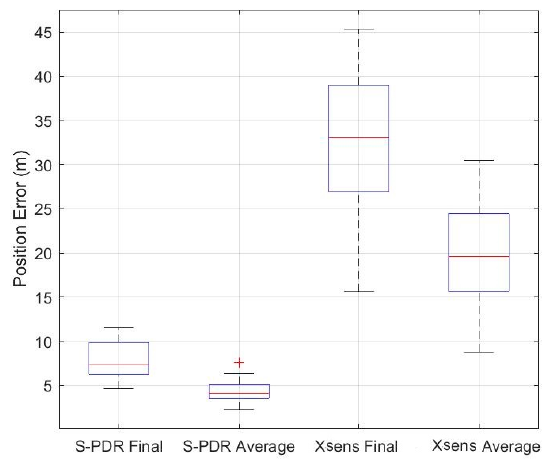
Figure 22. Boxplot of the errors of S-PDR vs. Xsens for indoor test.